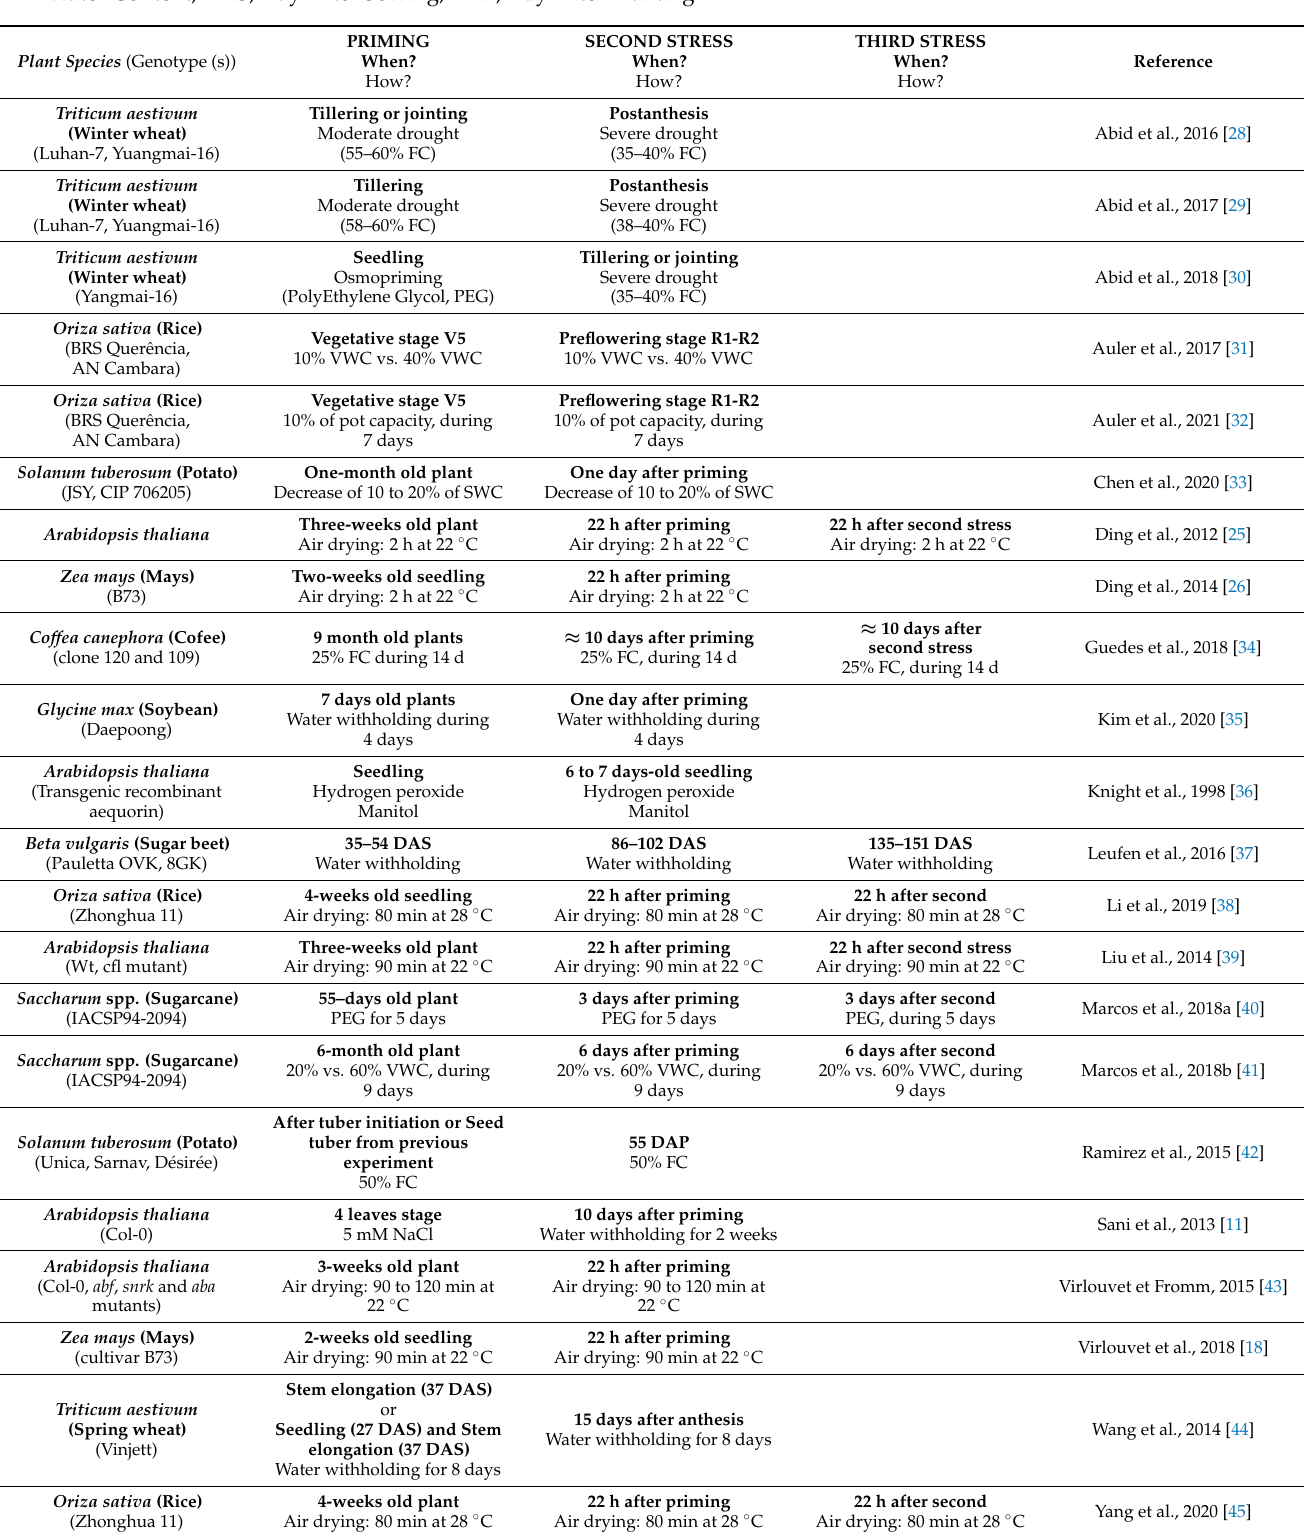
Table 1. Studies addressing recurrent water stresses in different crop species. For each study, the species, genotype and nature of each water stress is provided. FC, Field capacity; VWC, Volumetric Soil Water Content; SWC, Gravimetric Soil Water Content; DAS, Day After Sowing; DAP, Day After